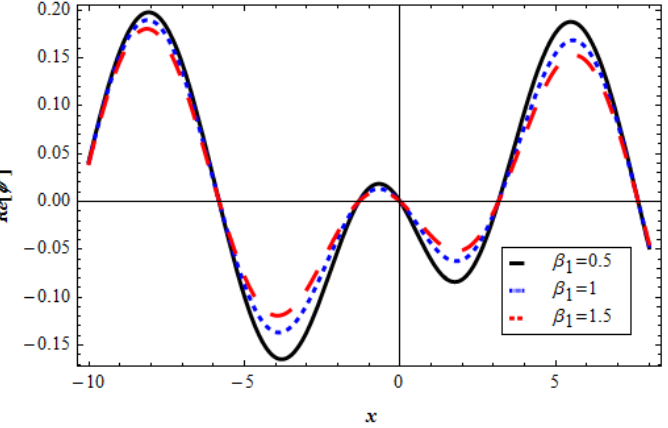
Figure 9. Change of solution (19) with z , t , β 1 for c = 0.5, v = 0.7, β 2 = 1, β 3 = 0, β 4 = 0.